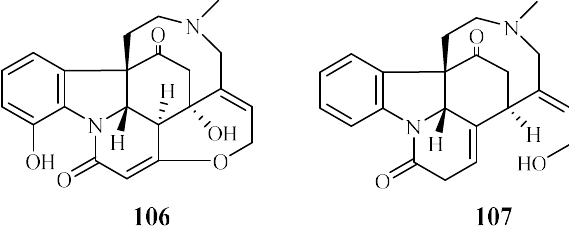
Figure 21. Compounds from a Loganiaceae plant.